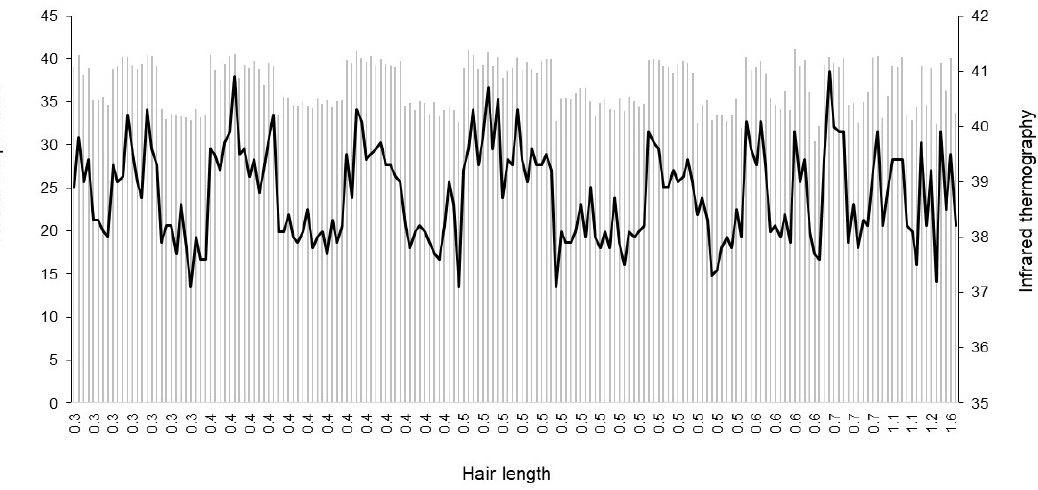
Figure 3. Hair length distribution according to rectal temperature (RT) and the superficial temperature of the lower side of the body (LS) obtained by infrared thermography.